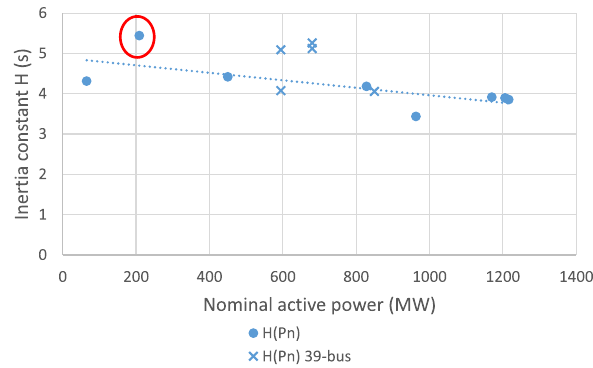
Fig. 11. Evolution of nuclear unit’s transient and subtransient time constants as a function of nominal active power in the 39- bus grid and according to [19].